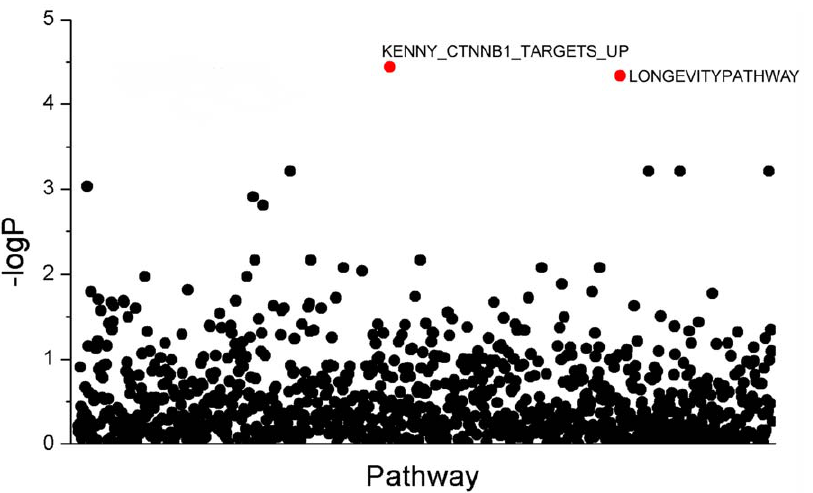
Figure 4. Plot of genome-wide MPPAS results of BMD. The significant pathways are highlighted in red. Significant pathways were defined by p values # 5.19 6 10 2 5 after Bonferroni correction(0.05/963).